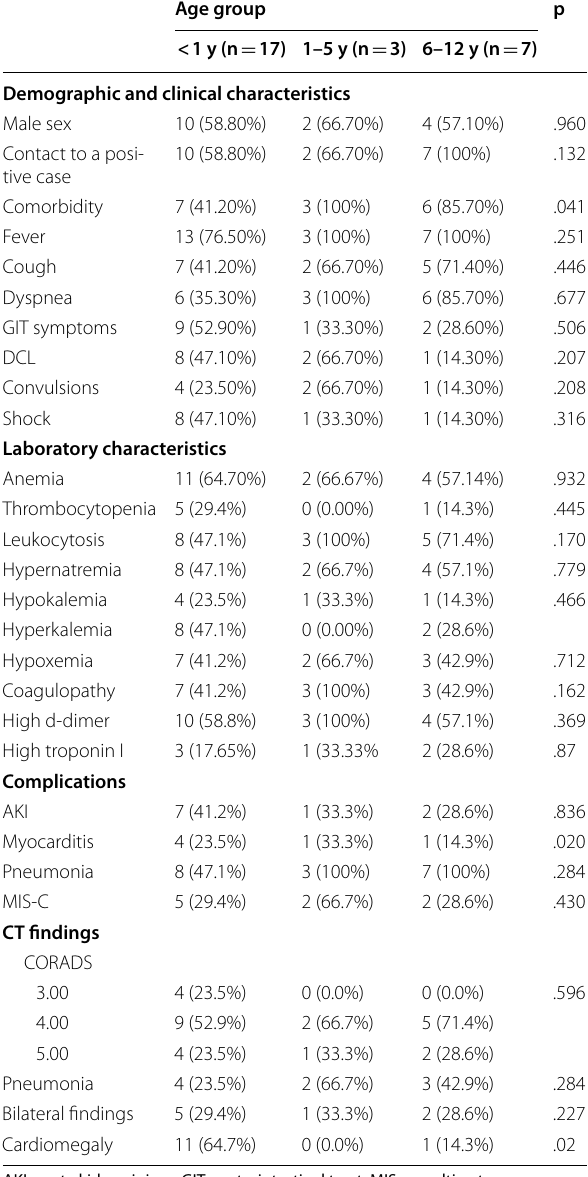
Table 2 Comparison between the three age